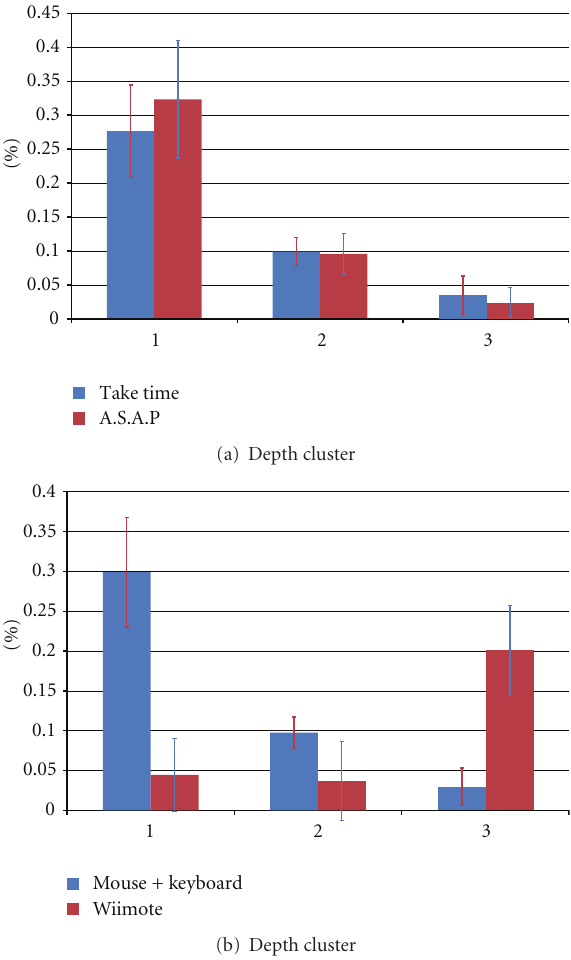
Figure 8: Percentage of chosen objects in the third dimension: (a) user attitudes; (b) interaction